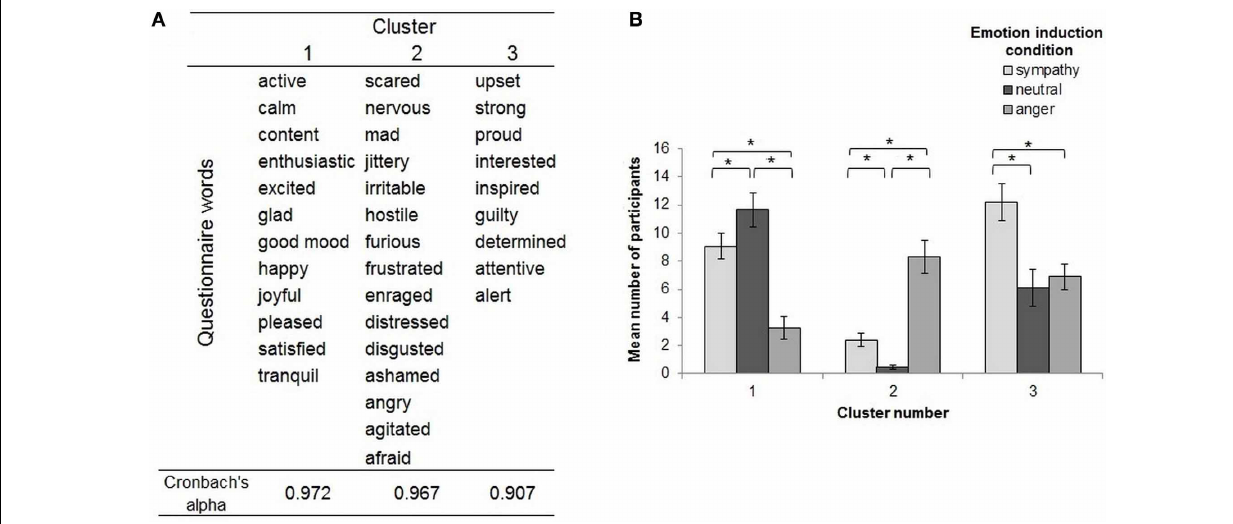
the cluster analysis, along with each cluster’s associated Cronbach’s alpha. (B) For each cluster of words (as identified by the cluster analysis), the figure